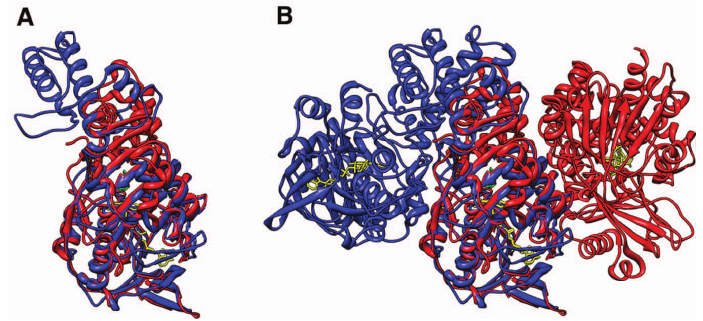
Figure 4 An overlay of the structures of monomers (A) and dimers (B) of L -amino acid oxidases (LAAOs) from the snake C. rhodostoma (red, PDB file 2IID) and the bacterium R. opacus (blue, PDB file 2JB2).